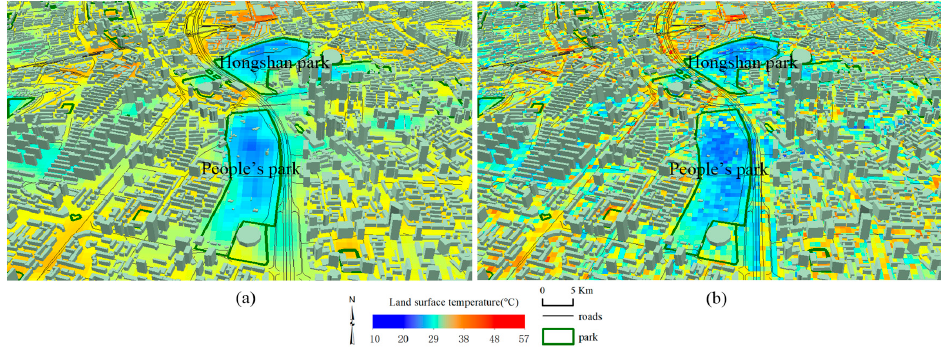
Figure 5. Local 3D architectural map of the study area: ( a ) is LST30m; ( b ) is LST10m.